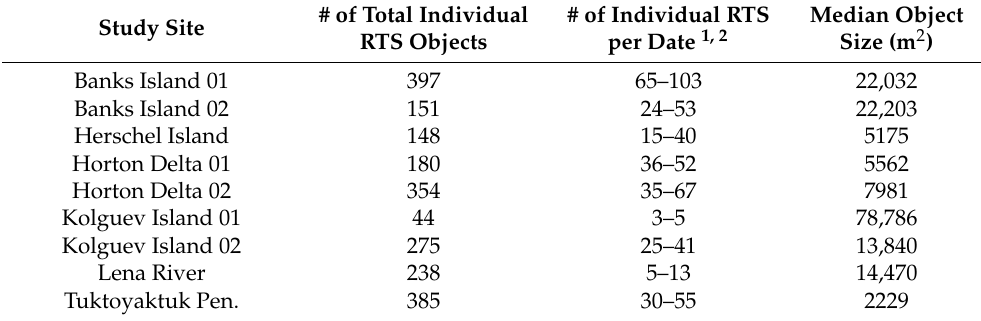
Table 2. Study sites with total number of detected RTS and number of individual RTS per date.